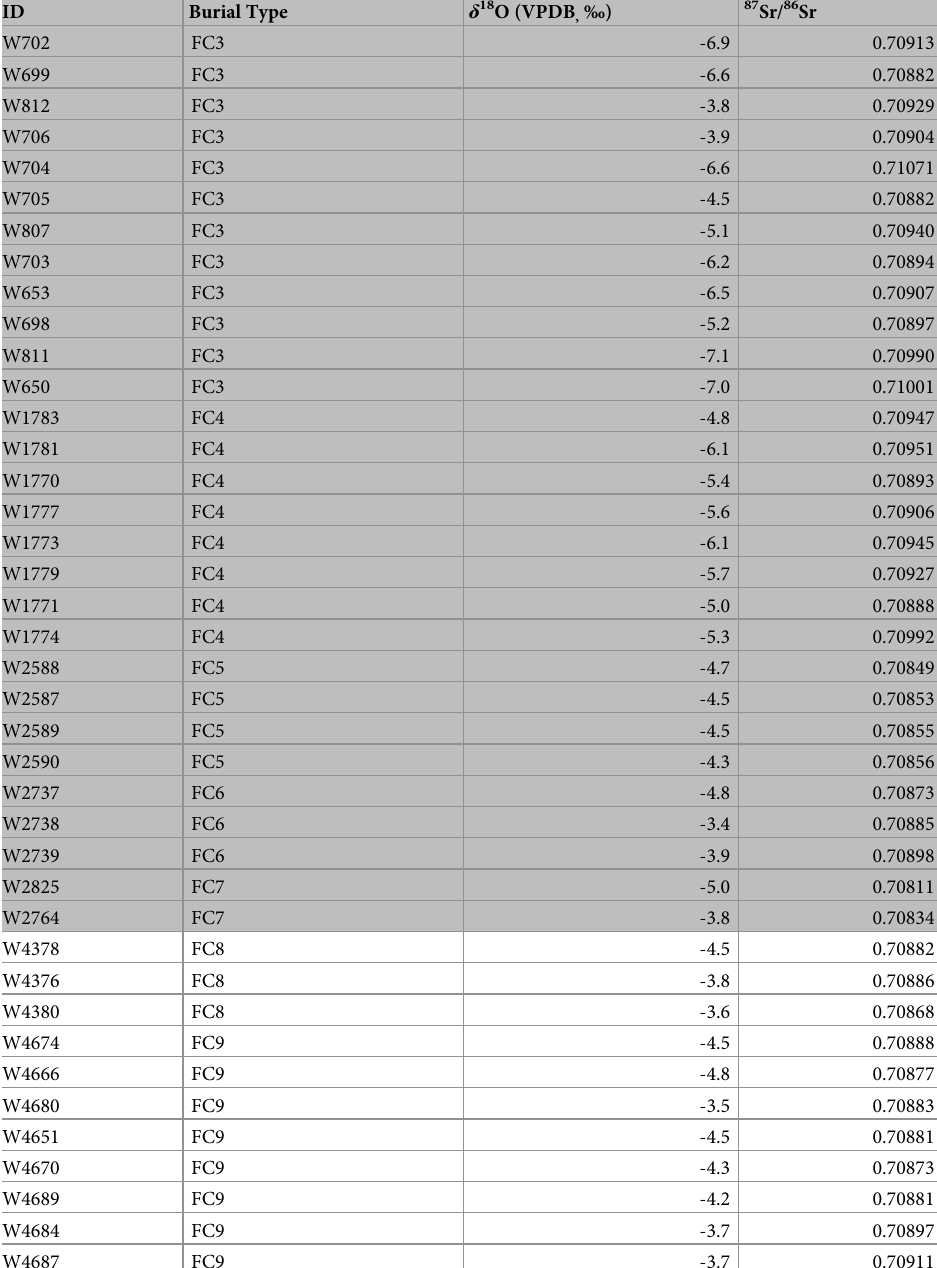
FC refers to the mass grave ( fossa comune ) in which individuals were